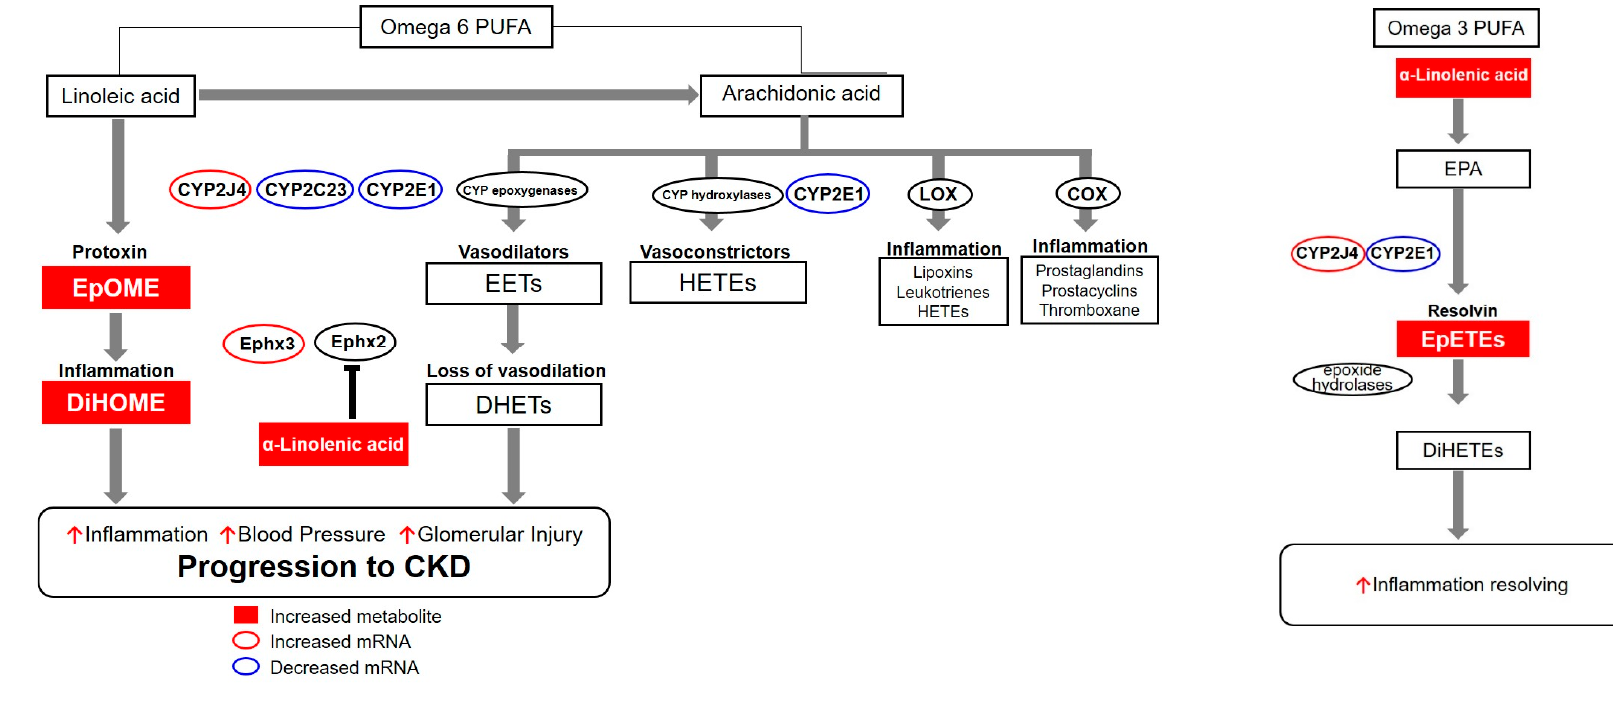
Figure 8. Potential mechanism of cytochrome P450 (CYP450)-dependent metabolism of polyunsaturated omega-6 and omega-3 fatty acids involved in CKD progression. ( a ) omega-6 PUFA pathway, ( b ) omega-3 PUFA pathway. Decreased mRNA expression of CYP2C23 and CYP2E1 prevent the production of EETs, as a vasodilator, from arachidonic acid. Increased mRNA expression of CYP2J4 induces the generation of EpOME and the corresponding DiHOME as a protoxin via the soluble epoxide hydrolase, leading to the progression of CKD. Metabolites in the red colored squares are increased. mRNA is increased in the red line circle and decreased in the blue line circle. CKD, chronic kidney disease; COX, cyclooxygenase; DHET, dihydroxyeicosatrienoic acid; DiHETE, dihydroxyeicosatetraenoic acid; DiHOME, dihydroxyoctadecenoic acid; EETs, epoxyeicosatrienoic acids; EPA, eicosapentaenoic acid; Ephx2 , epoxide hydrolase 2; Ephx3 , epoxide hydrolase 3; EpOME, epoxyoctadecenoic acid; EpETE, epoxyeicosatetraenoic acid; HETE, hydroxyeicosatetraenoic acid; LOX, lipoxygenase; PUFA, polyunsaturated fatty acid.